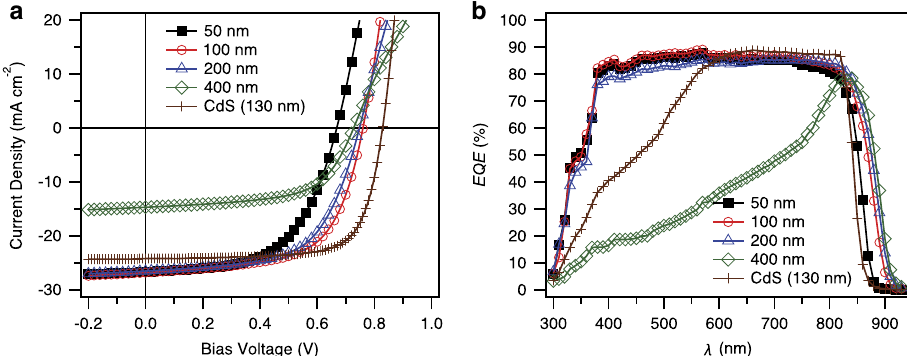
Figure 1 | Photovoltaic properties. ( a ) J–V curves and ( b ) EQE measurements for CdSe layer thicknesses of 50, 100, 200 and 400nm, and a CdS window layer cell with a 130nm-thick CdS